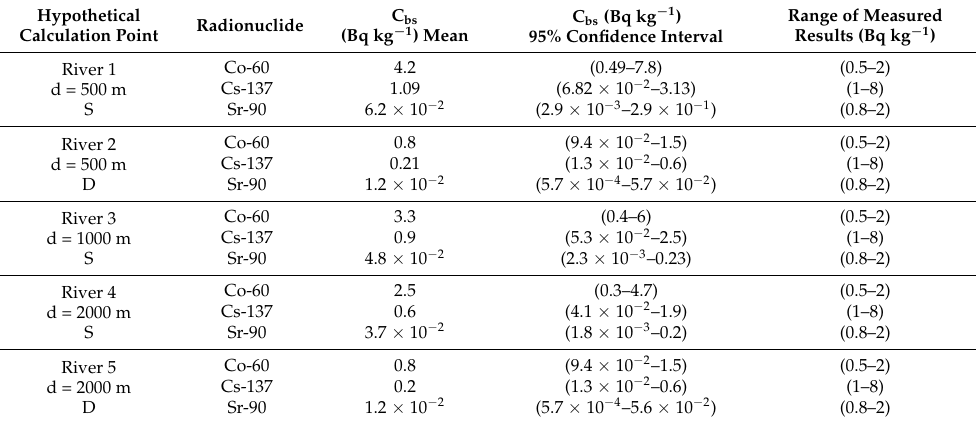
Table 4. Modelled results obtained for radionuclide concentrations in bottom sediments (C bs ) due to liquid releases from Asc ó NPP and the range of reported measured values [12]. Note: S—same shore; D—different